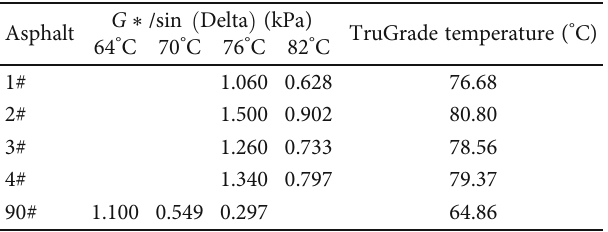
Table 6: Dynamic shear rheological test results of tire rubber powder-modi fi ed asphalt. Asphalt